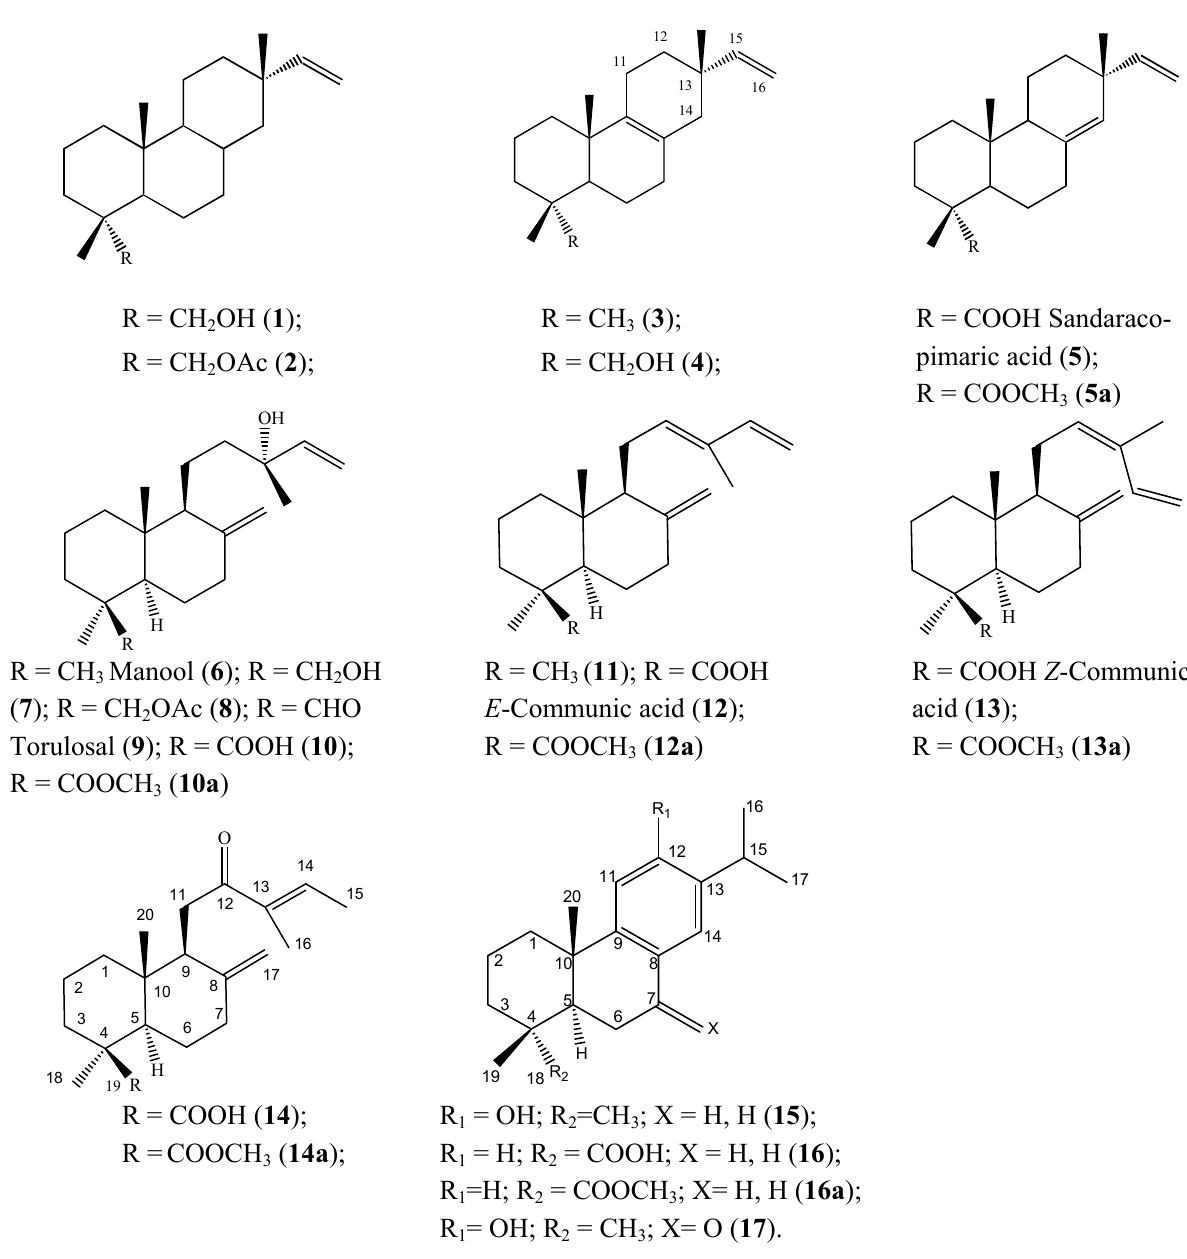
Figure 1. Structure of the compounds isolated and/or identified from the resin of Austrocedrus chilensis